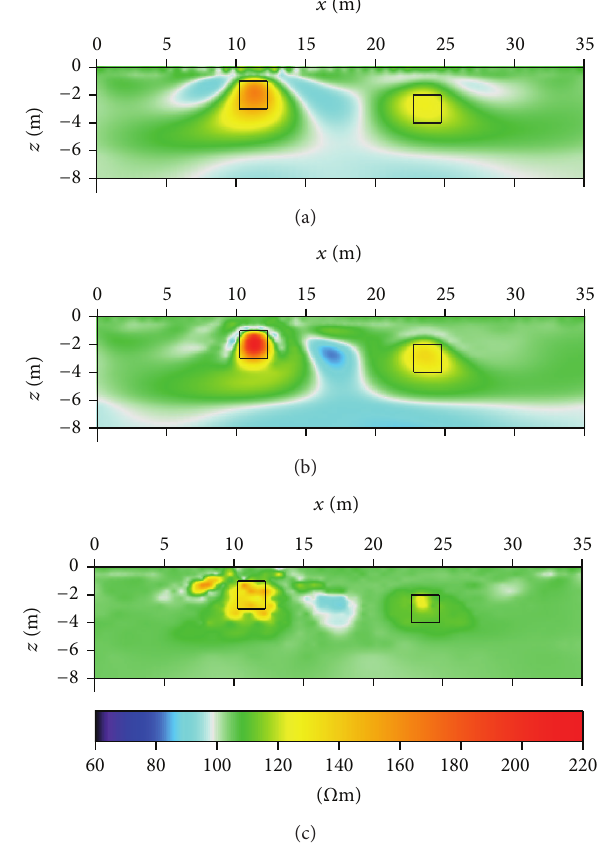
Figure 5: Results of filtered Jacobian damped LSQR imaging obtained by varying correction parameter 𝜒 . (a) 𝜒 = 0.5, (b) 𝜒 = 5, and (c) 𝜒 = 50. The model is the same as that in Figure